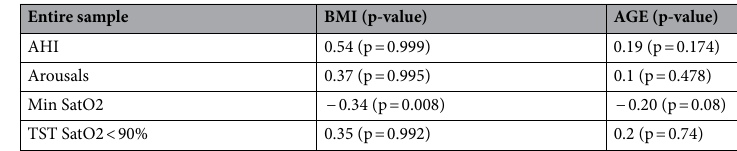
Table 4. Pearson’s correlation (entire sample) between BMI and AGE with AHI, arousals, minimum O2 saturation and total sleep time with < 90% O2 saturation. N = 48; AHI: Apnea Hypopnea Index; Min SatO2: minimum saturation of O2); TST SatO2 < 90%: total sleep time with saturation of O2 below 90%.